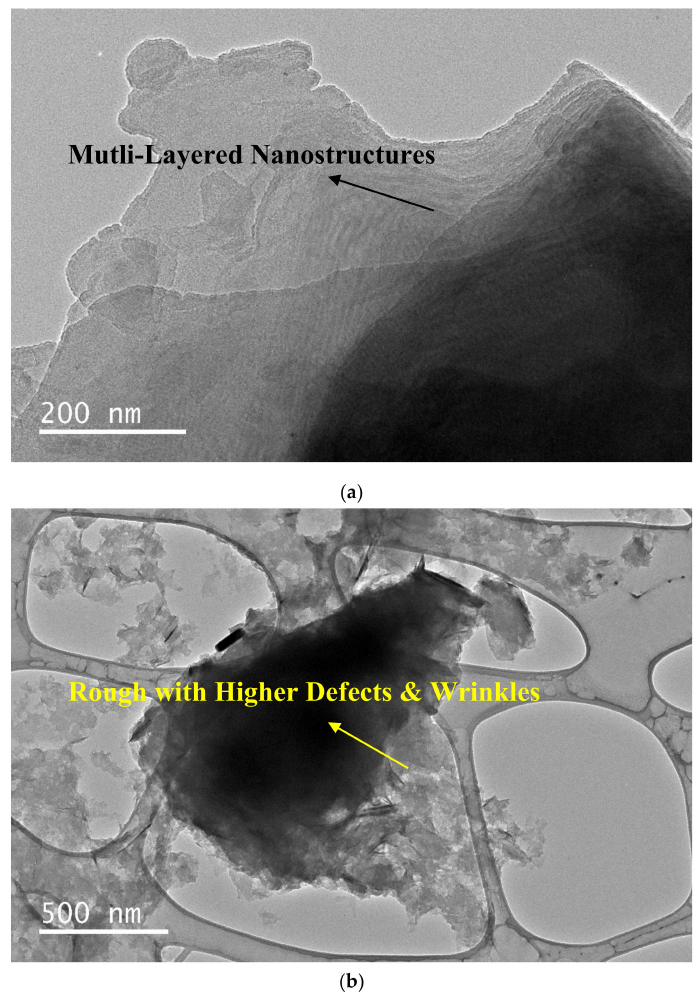
Figure 8. HR-TEM image of pristine GNPs ( a ) and functionalized GNPs ( b ) dispersed in